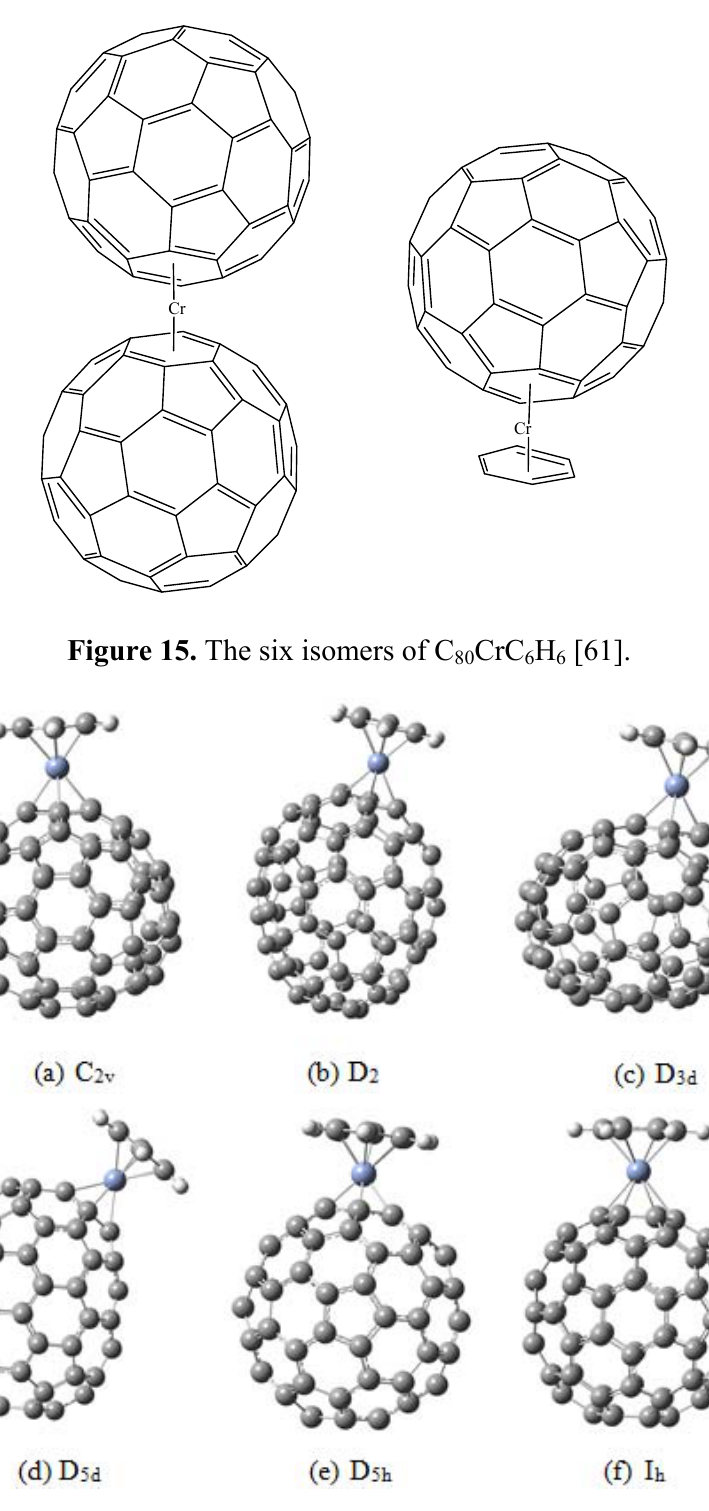
Figure 14. Hybrid compounds suggested by Salcedo [59].